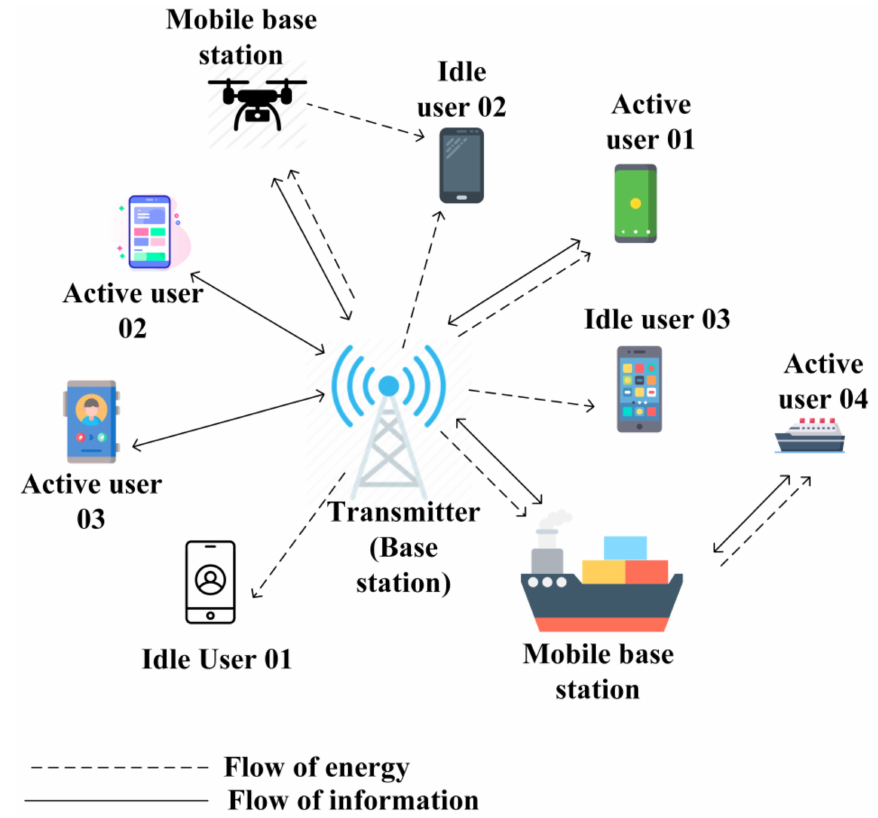
Figure 5. Flow of information and energy in SWIPT using static and mobile base